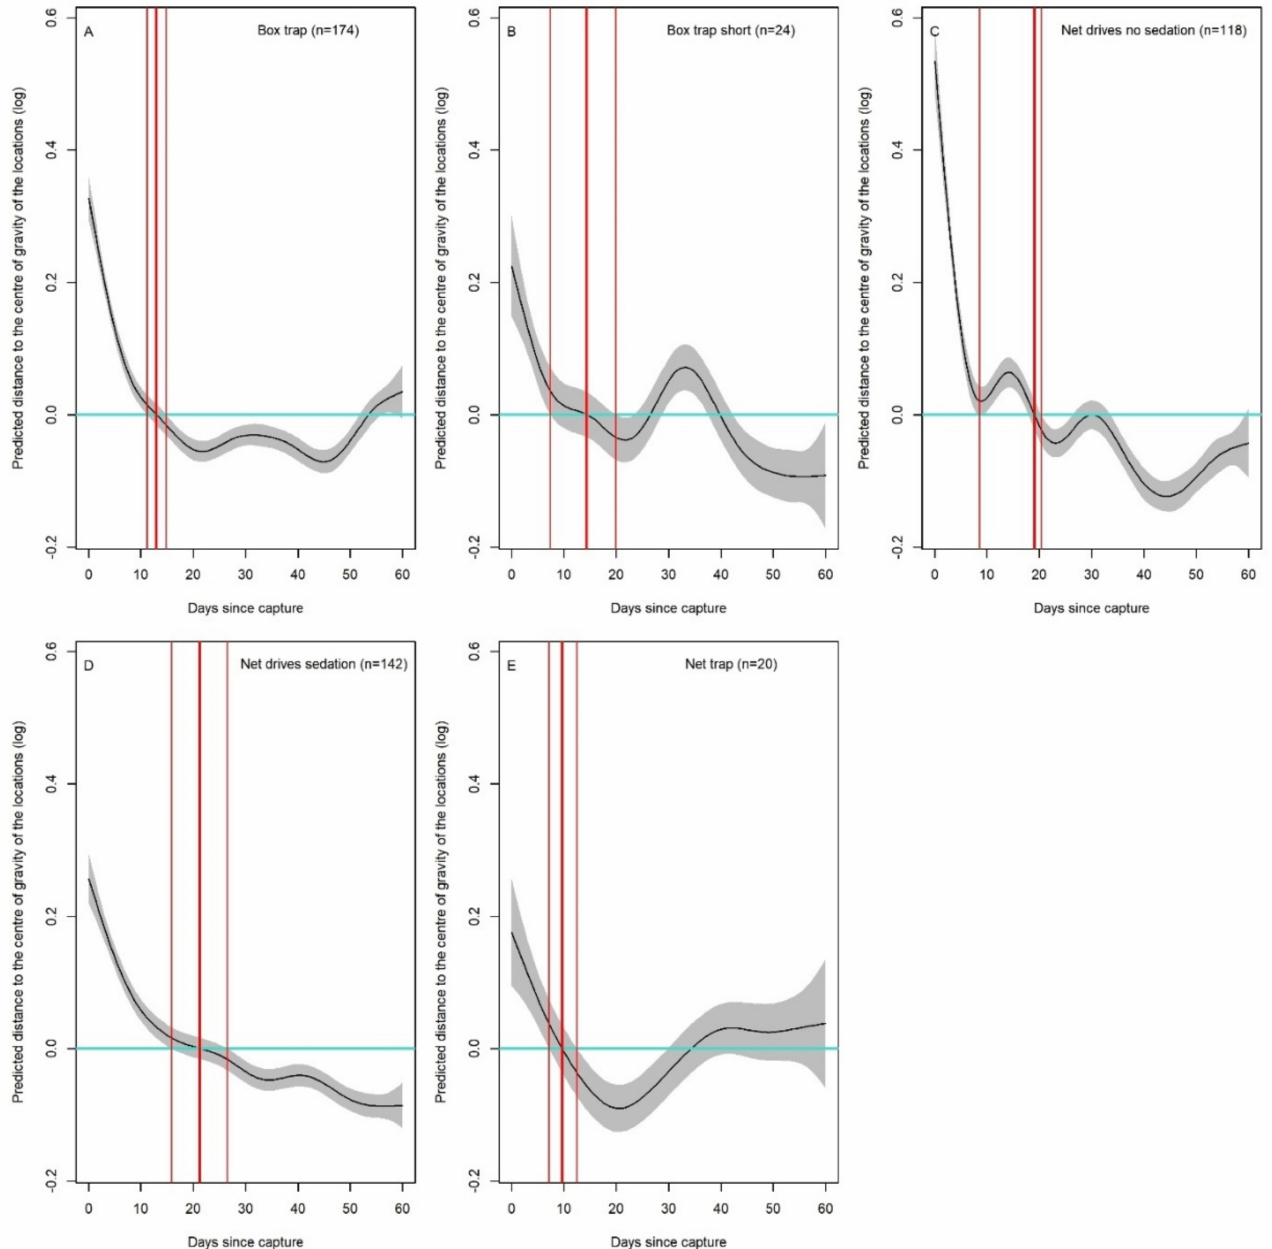
Figure 1. ( A – E ). Number of days after capture and release to rebound to the individual-specific average log-transformed distance to the centre of gravity of locations (thick red vertical line), the average distance +SE and the average distance − SE (thin vertical lines), across the different capture methods. The model is centred on zero, i.e., the plotted values sum to zero that hence represents the average distance (blue line: no effect). When the line crosses zero, it implies the distance has ‘rebounded to the overall average